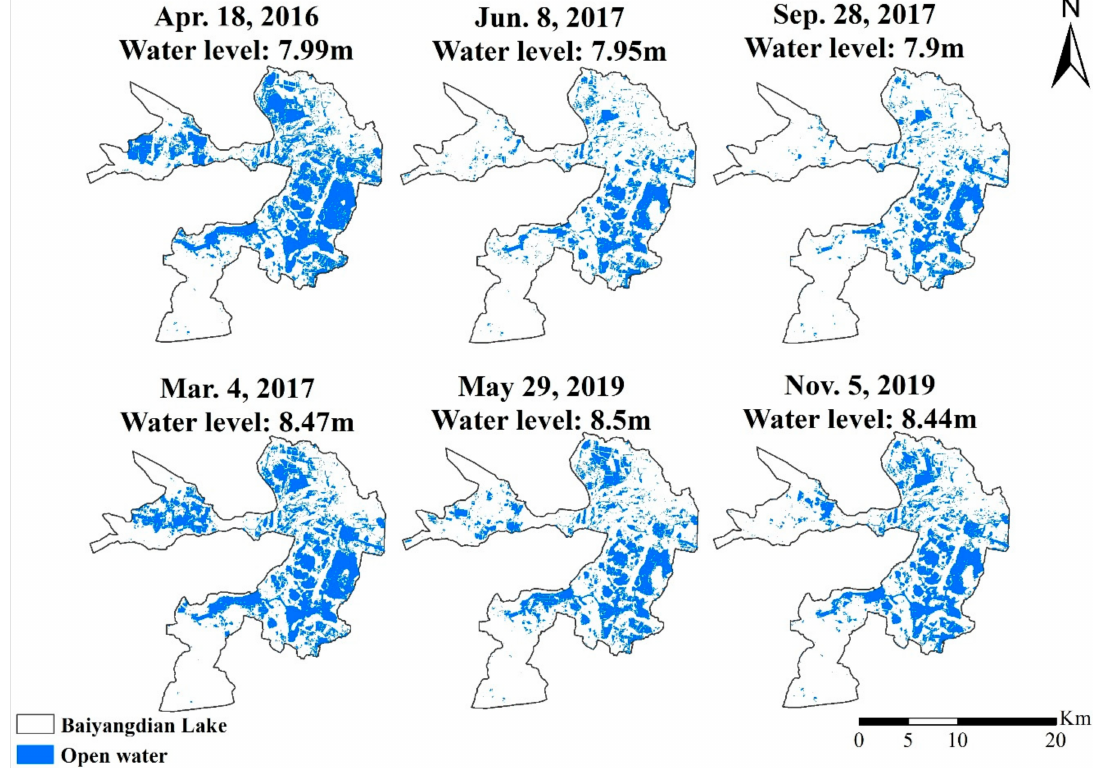
Figure 5. Water surface distributions corresponding to water levels of 7.95 and 8.50 m in spring, summer, and autumn, derived from Landsat 8